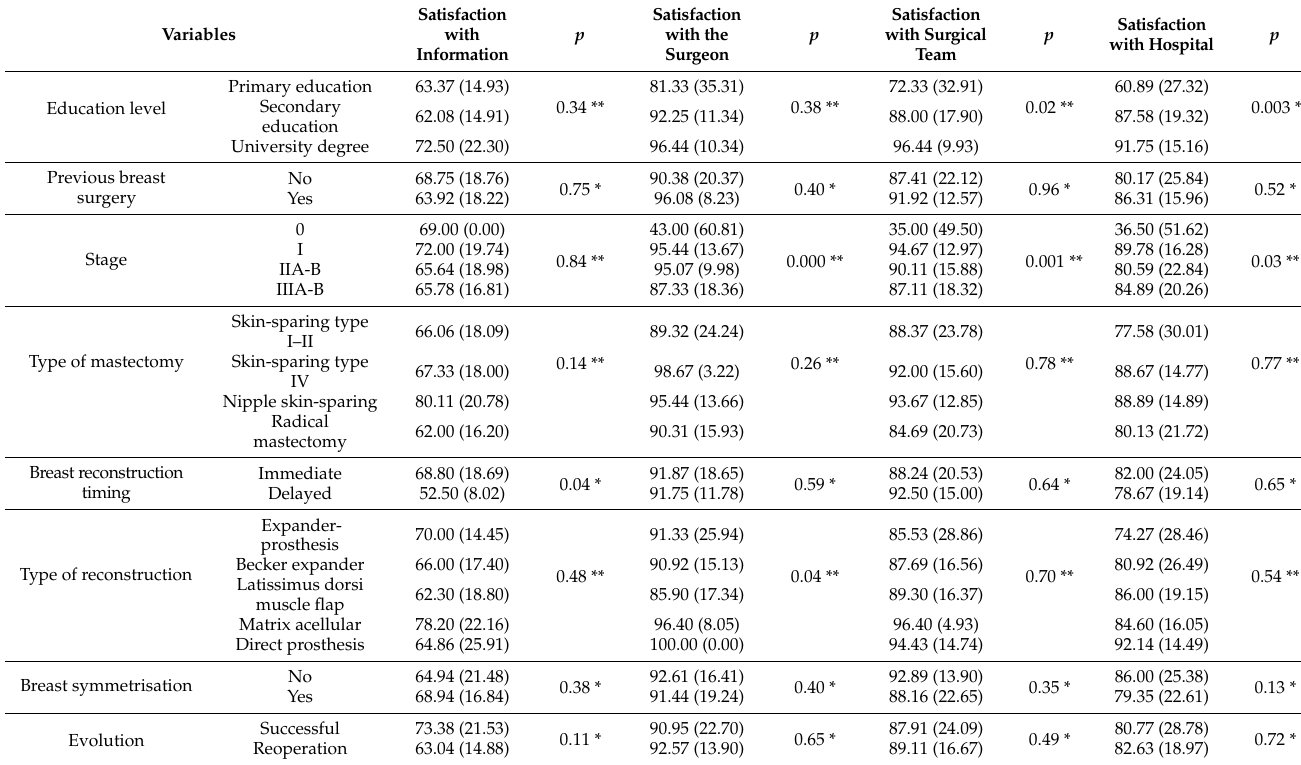
Table 9. Differences between satisfaction with care scales mean scores and most important qualitative variables studied. Variables